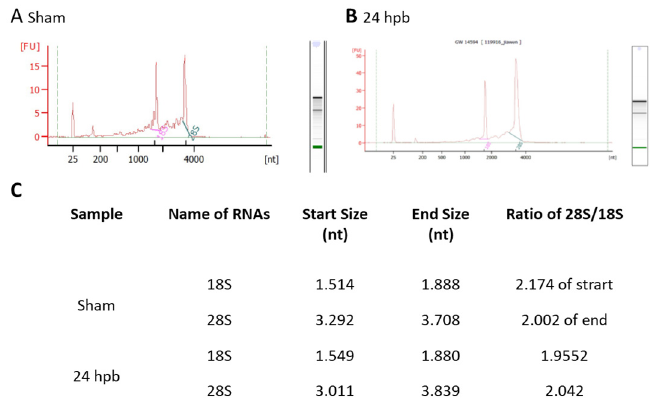
Figure 1. Highly intact RNA: RNA was purified from heart tissues using the Qiagen RNeasy Mini Kit. The purified RNA was analyzed using a Beckman 700 system (ratio of 28 S to 18 S rRNA: ≥ 1.55), NanoDrop 2000, and Agilent 2100 Bioanalyzer (ratio of 28 S to 18 S rRNA: ≥ 1.7). A high RNA integrity number (RIN) of 9.6 was obtained, indicating highly intact RNA. ( A ) sham; ( B ) 24 hpb; ( C ) real values from Agilent 2100 Bioanalyzer.